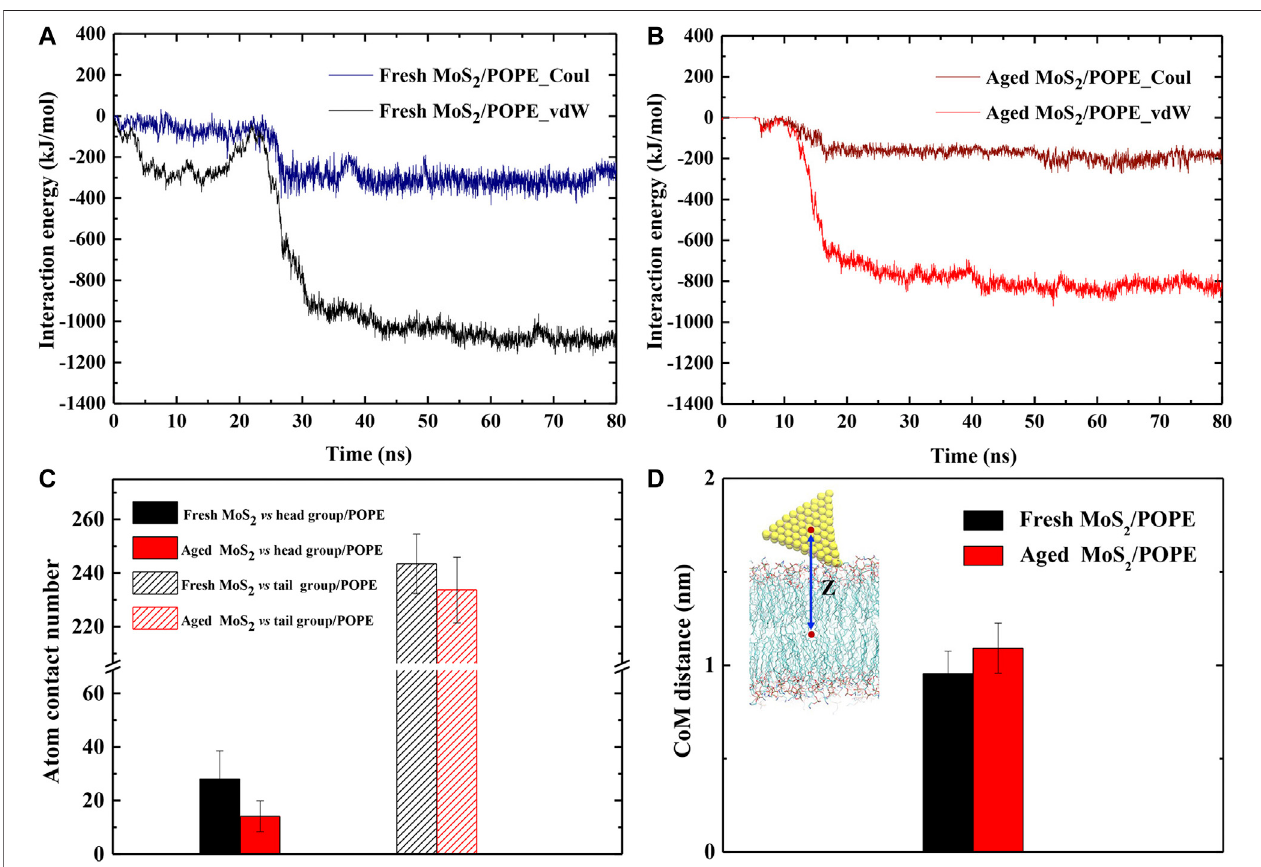
FIGURE 4 | Surface aging affects the interactions of MoS 2 with the lipid membranes. The time-dependent interaction energies (vdW and Coul energies) between the (A) fresh and (B) aged MoS 2 nanosheets and the POPE lipid membrane during the insertion processes. (C) The average atom contact numbers between the fresh/ aged MoS 2 nanosheets and the head/tail groups of POPE lipid molecules. (D) The average center of mass (CoM) distances between the fresh/aged MoS 2 nanosheets and the POPE lipid membrane.